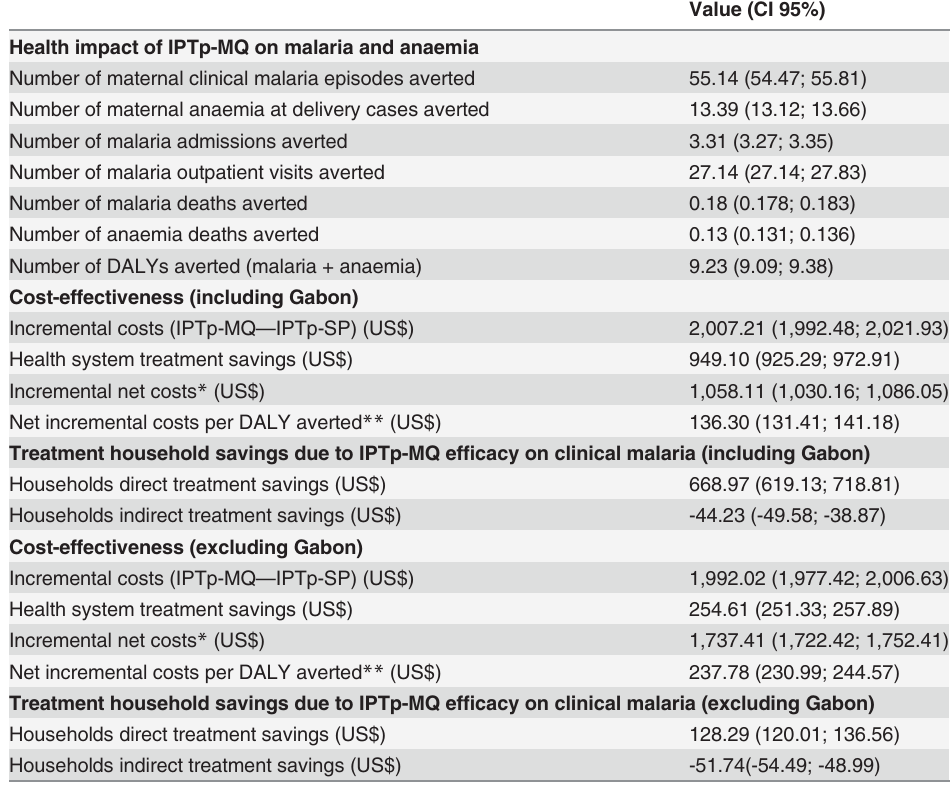
Table 3. HIV-negative trial: Results of cost-effectiveness analysis (per 1000 pregnant HIV-negative